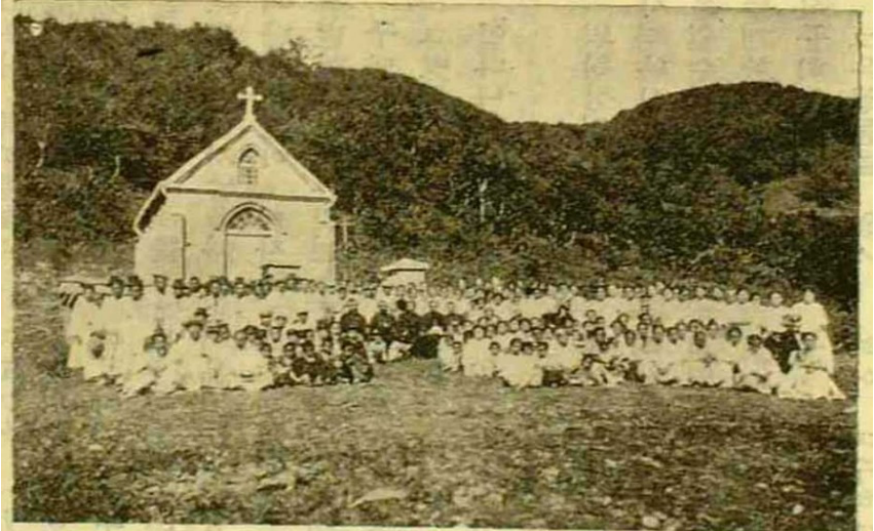
Figure 4. Image of the Memorial Church in 1932 [source: Catholic Youth , vol. 2, n. 9 (September 1934), p. 91].